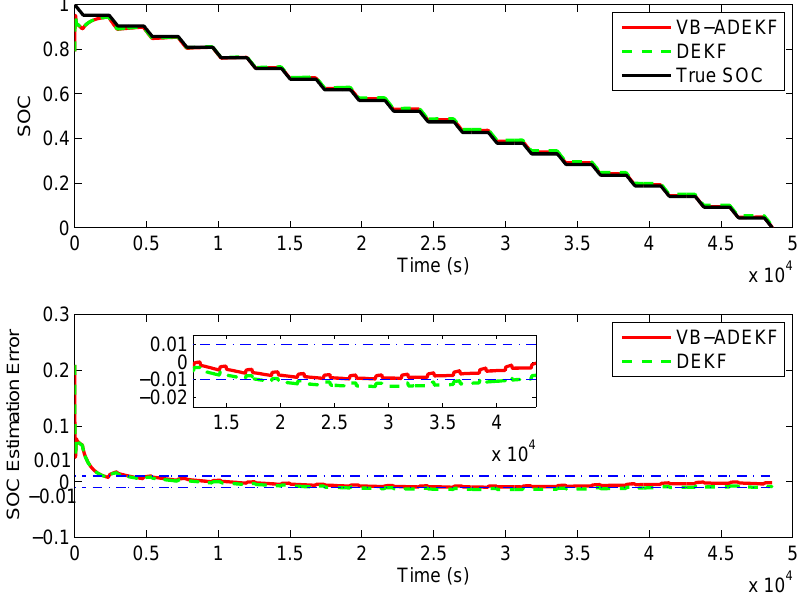
Figure 9. SOC estimation results using VB-ADEKF and DEKF in the pulse current discharge